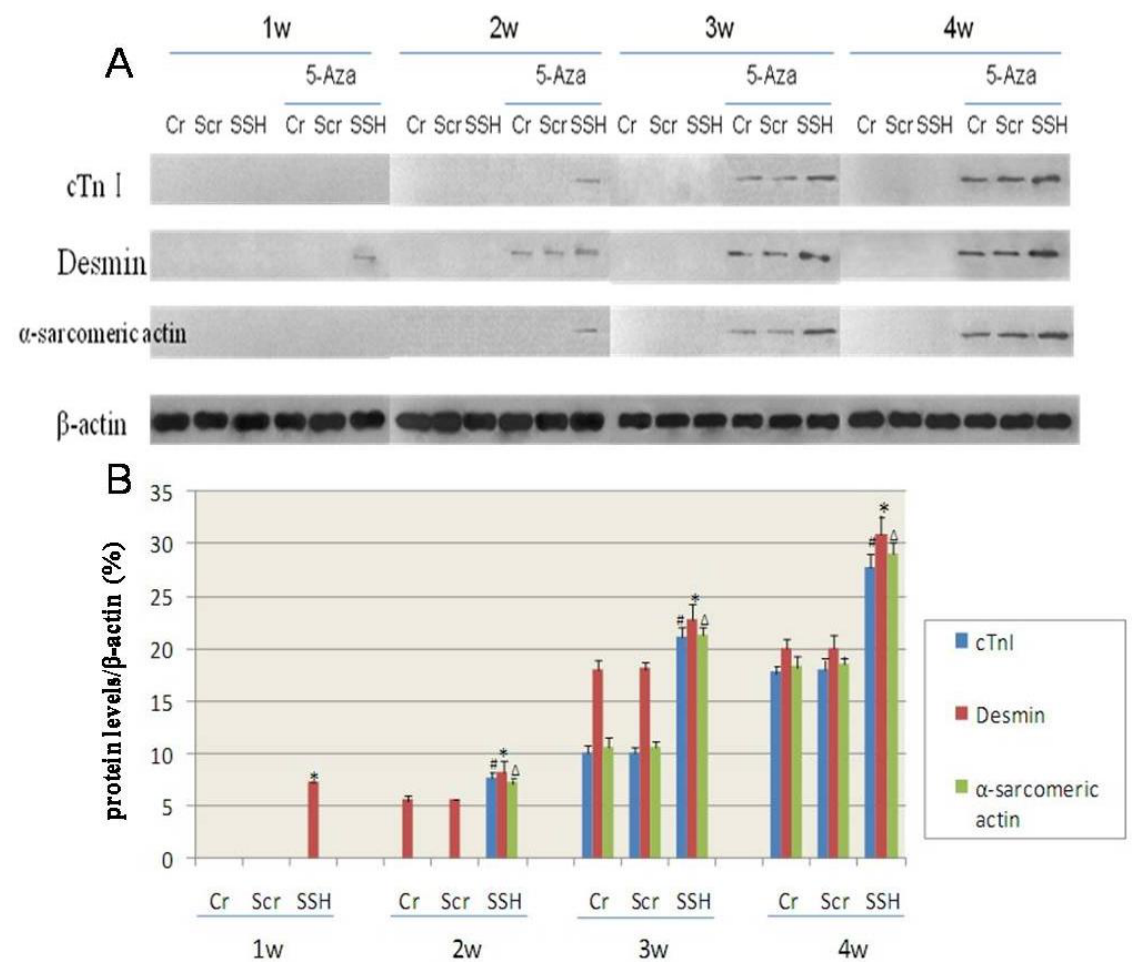
Figure 10. The effect of SSH1L on the expression of cardiac-specific proteins of cardiomyocyte-like cells differentiation induced by 5-Aza. Cardiac-specific proteins were detected by western-blot ( A ). ( B ): The qualified data image of cardiac-specific proteins expression ( p < 0.05 cTnI:#; Desmin:*; α-sarcomeric actin:∆). The cardiac-specific proteins increased along with the increased induction time, and the expression level was much higher in the SSH group than in the other two control